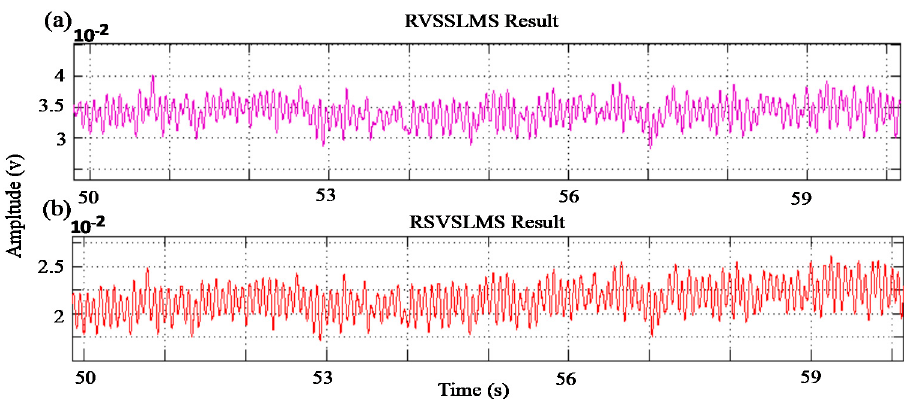
Figure 21. Comparison of retrieved EMT signal using multi-channel noise cancellation techniques: ( a ) regularized variable step-size LMS (RVSSLMS); and ( b ) regularized sigmoid variable step-size LMS (RSVSLMS). The displayed result with a time frame of 50 to 60 s is extracted from the first 100 s time band data. The images are the processing result after combining the adaptive noise canceling output with 10 Hz sine wave signal.